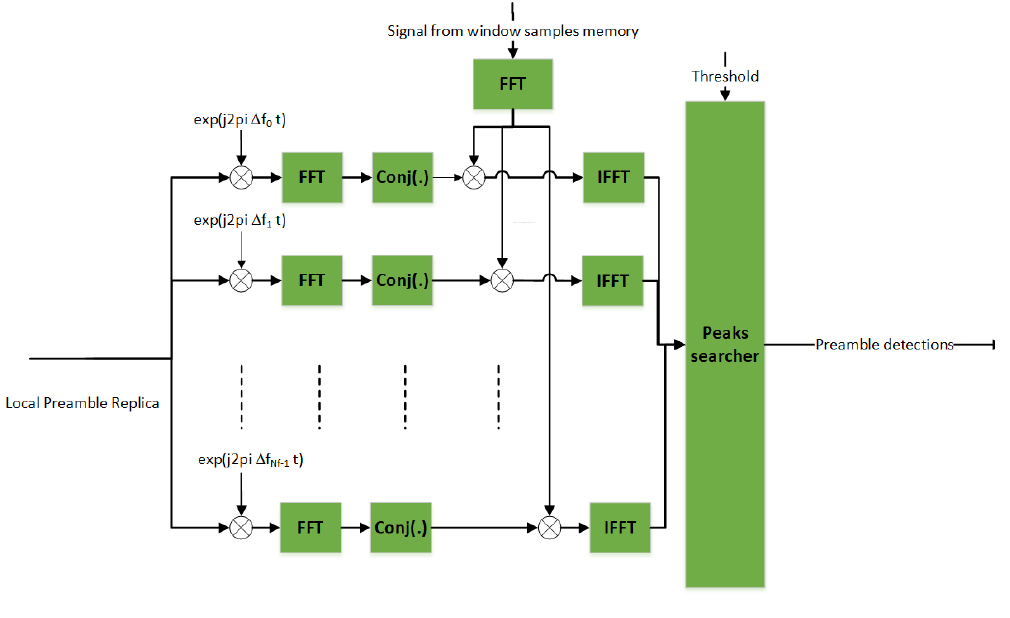
Figure 5. Coherent